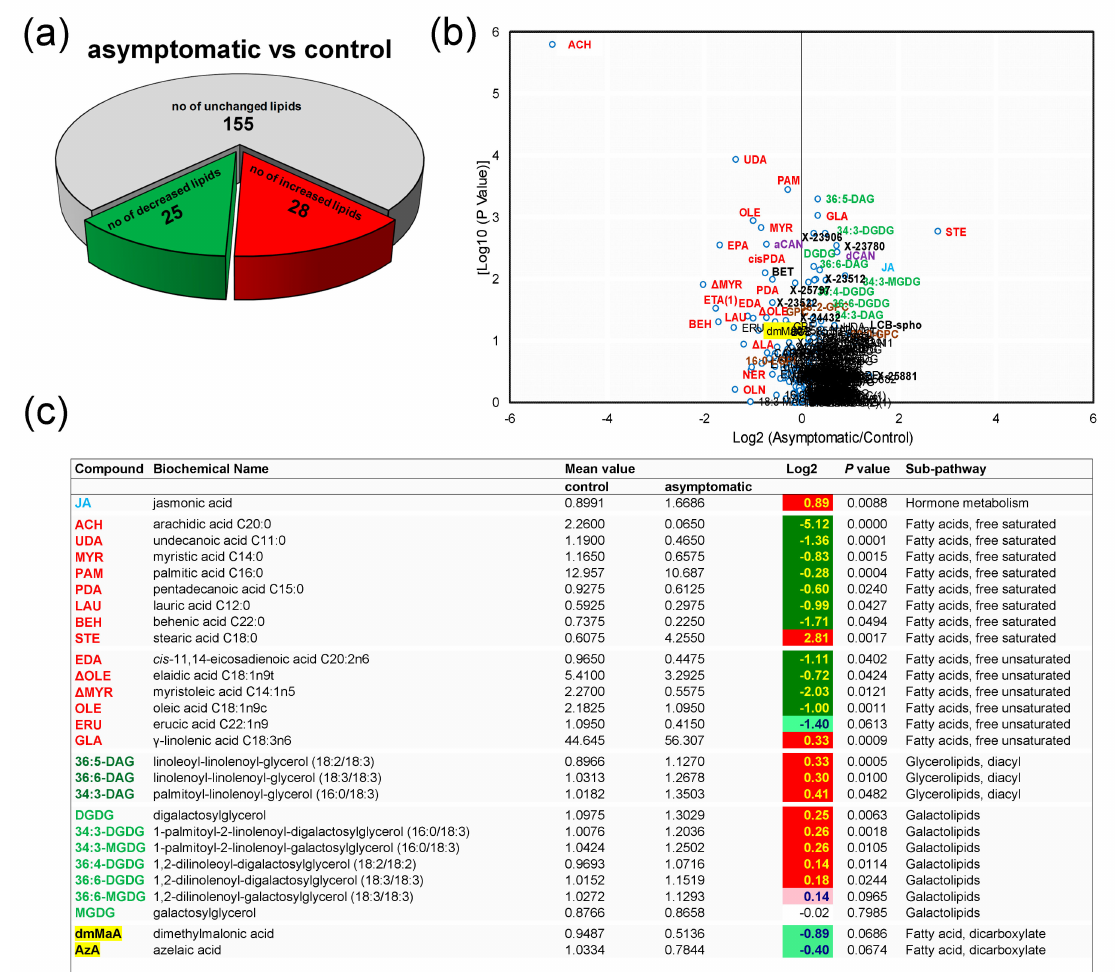
Figure 2. Variations in levels of hormones, lipid species, and other compounds of the metabolism of lipids in Vitis vinifera L. ‘Malvasia fina’ a ff ected by Esca complex disease (ESCA): ( a ) Pie plot representing the numbers of altered species in healthy leaves from foliar-asymptomatic and wood-symptomatic vines (ASY) relative to healthy leaves from healthy una ff ected control vines (CTL). Levels were considered altered when they underwent a p -value ≤ 0.10 (Welch’s two-sample t -test, n = 6). ( b ) Volcano plot (log2 (ASY / CTL) vs. [log10 ( p -value)]) illustration of species di ff erently accumulated in CTL and ASY. Abbreviations are as listed in Figure 2c and Table S1. ( c ) Representative compounds listed along a color gradient according to sub-pathways. Additional altered compounds can be found in Table S1. For log2 values, di ff erent colors represent di ff erent directions of change at p ≤ 0.05 (dark green = negative change; red = positive change) and at p ≤ 0.10 (light green = negative change; rose = positive